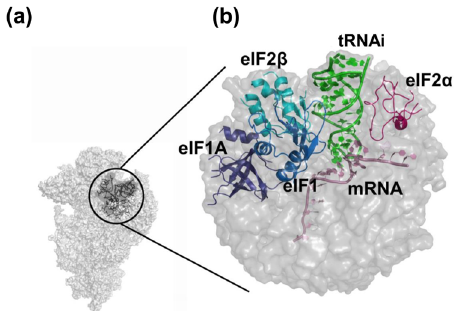
Fig. 3 Relative binding energy pro fi les of near cognate (GUG and AUA) codon-anticodon interactions with respect to AUG. The simulation runs were carried out in the presence and absence of different eIFs. For GUG and AUA, for each case, the relative binding energy is calculated with respect to AUG codon for the similar system and then the average relative binding energy is plotted as bar. The error bars indicate the standard errors obtained from the mean of relative binding energies from four independent simulation runs. AUA shows much lower relative binding energy in the absence of eIF1 alone, eIF1 and eIF1A or eIF2 α . Supplementary Data 2 contains the relevant source